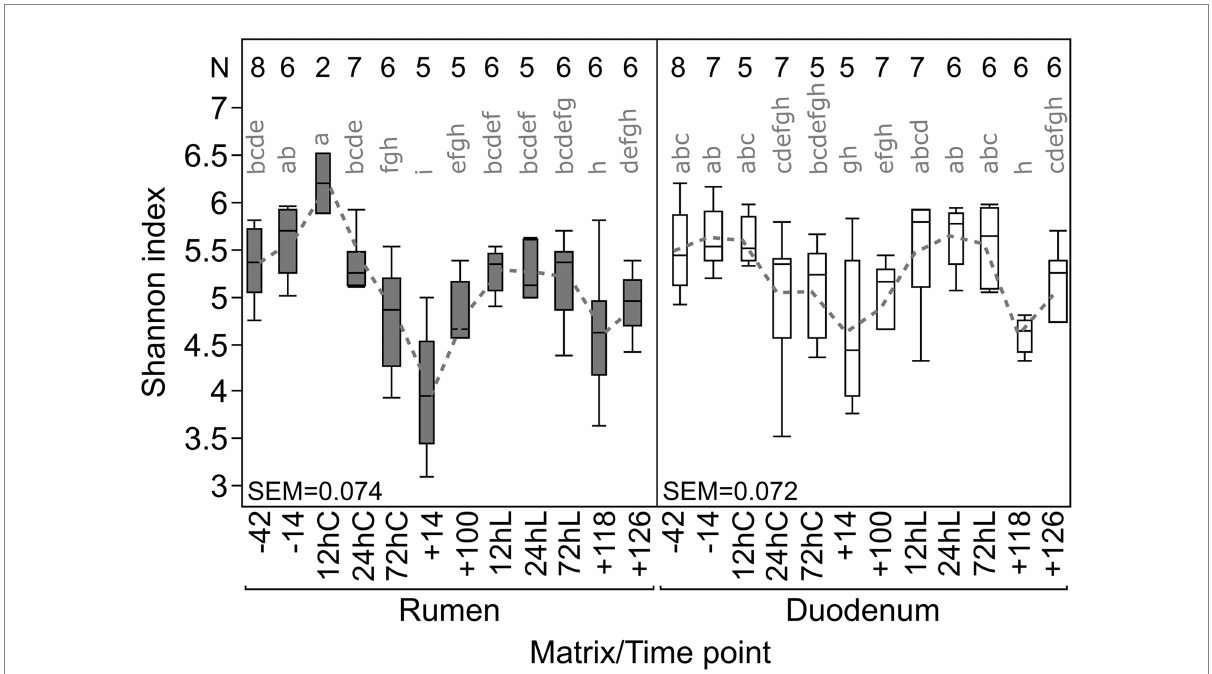
FIGURE 3 Individual Shannon diversity index throughout the complete trial period for rumen and duodenal fluid samples. Time points including a “–” or “+” indicate days antepartum or postpartum and time points including “hC” or “hL” are samples taken at 12, 24, or 72 h after calving or LPS challenge, respectively. N -Values refer to total samples included per time